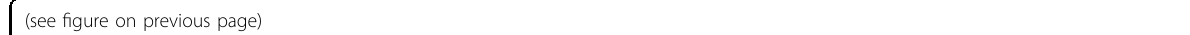
Fig. 5 Cytosolic serine levels controlled by SHMT1 modulate ROS formation and ATP/energy pro fi le. Effect of nutrients on ATP and ROS levels in A549 cells. The effect of 400 μ M Ser ± 4LFPG or Gly ± SARC supplementations, on ATP levels ( A ) and ROS production ( B ) in A549 cells grown in MEM as compared to cells grown in complete medium RPMI or 50% brain extracellular fl uid (BEF). Effect of the inhibition of Ser/Gly uptake on ATP ( C ) and ROS levels ( D ) in A549 cells grown in RPMI complete (10% FBS) or 50% BEF in MEM. The levels of the indicated parameters were assayed after incubation of the cells with 100 μ M of 4LFPG and/or SARC. ATP concentration measured for RPMI ( A ) and Ct ( C ) are 29.4 ± 3.4 nmol/mg protein and 19.6 ± 1.9 nmol/mg protein, respectively. For all the experiments in ( A – D ) n = 4. OCR ( E ) and ECAR ( F ) analysis ( n = 4) of A549 cells in RPMI (black) or RPMI with increased serine concentration (385 μ M, blue in the fi gure) and in combination with 4LFPG (red); a representative experiment is shown (data are the mean of at least fi ve wells ± SD). Asterisks refer to P values for serine vs. 4LFPG. P values for RPMI vs. serine samples are <0.01 for both OCR and ECAR (not shown). G Migration of A549 cells to 50% serum after treatment with 25 μ M SARC alone or in the presence of 50 μ M NADPH or GSH or with 25 μ M ATP or hypoxanthine 12,46 . The graphs represent three independent experimental replicates. * P < 0.05; ** P < 0.01; *** P <